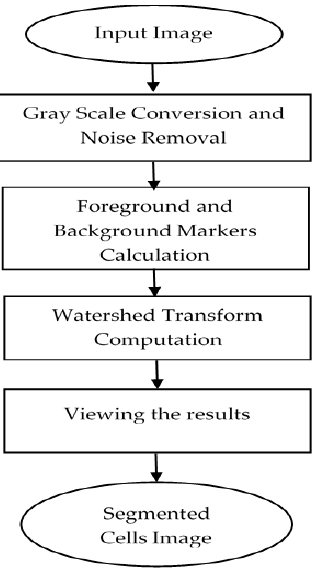
Figure 6. Flowchart of proposed marker controlled watershed transformation.